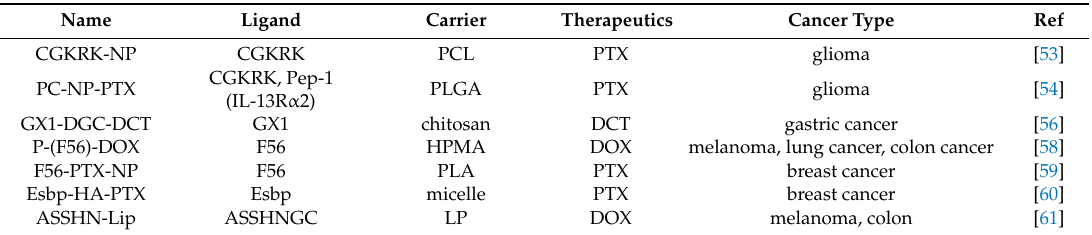
Table 3. Peptide-modified